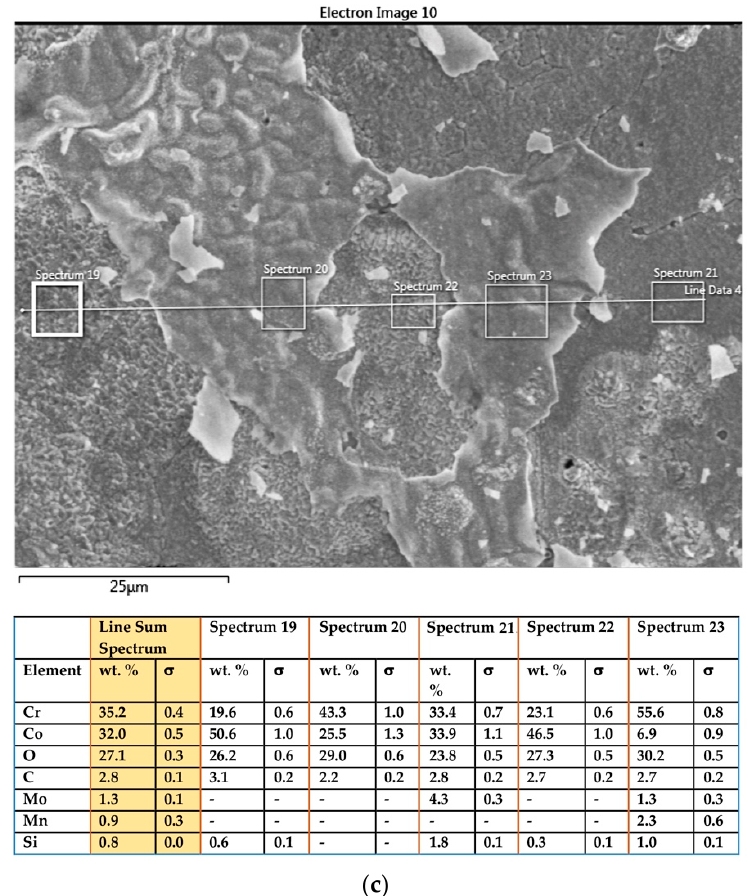
Figure 3. SEM–EDS results for sintered SM-HT: ( a ) SEM-SE micrograph with corresponding EDS line on the right; ( b ) the surface distribution of O, Co, Si, Cr, Mo, C; ( c ) EDS results from marked micro-areas.